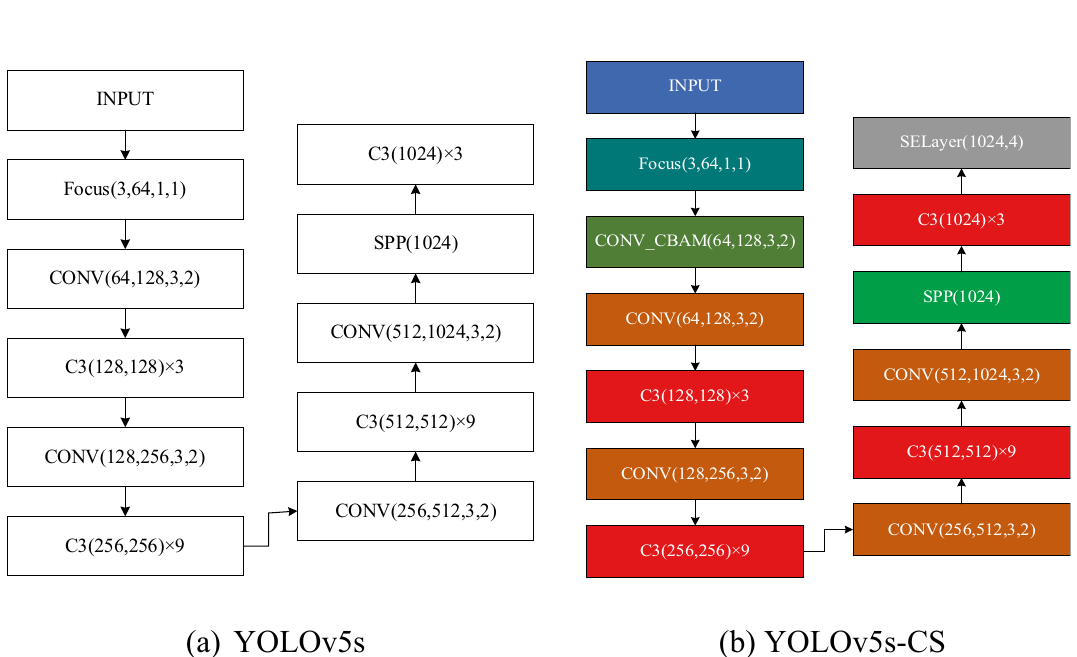
Figure 3. YOLOv5 backbone network structure before and after